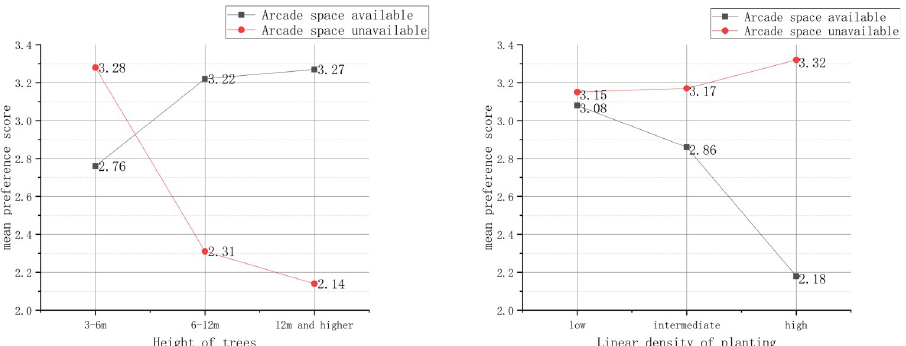
Fig 2. Height of trees and linear density of